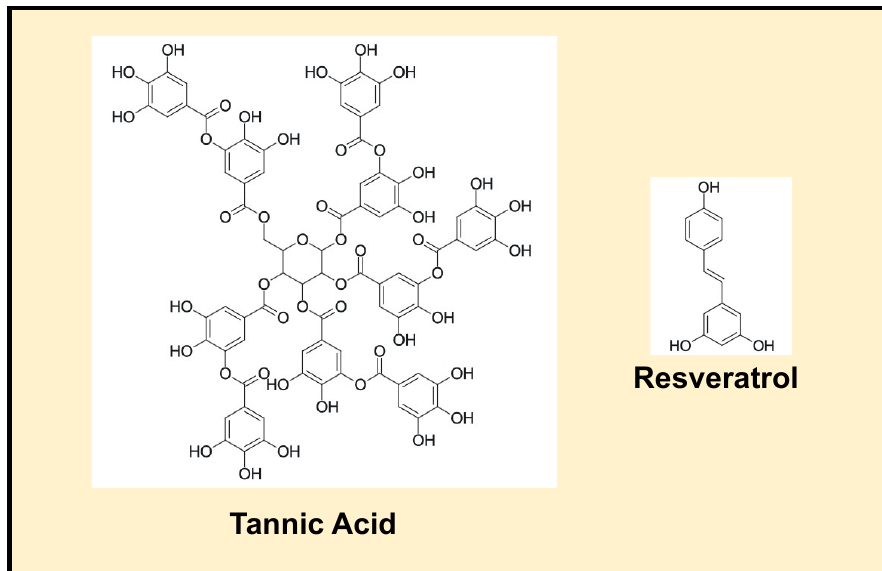
Figure 1. Structures of tannic acid and resveratrol.